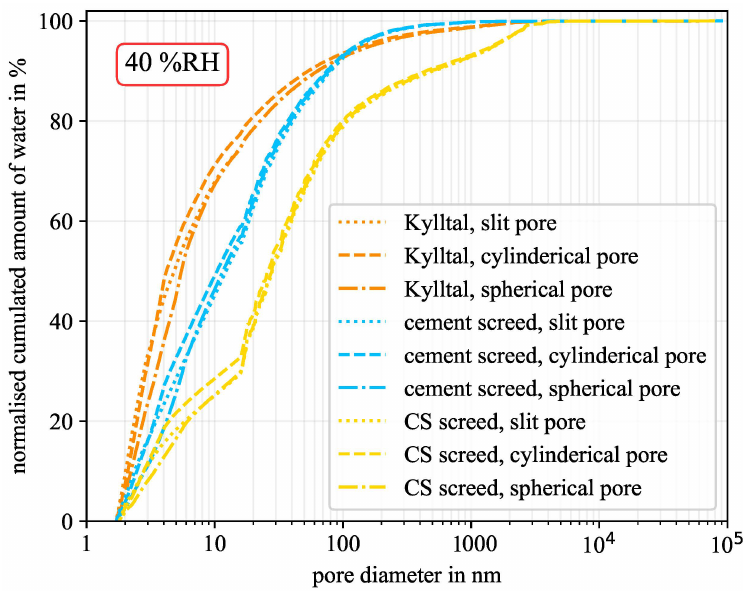
Figure 4. Normalised cumulated amount of water at 40% RH for the three pore geometries. (CS—calcium